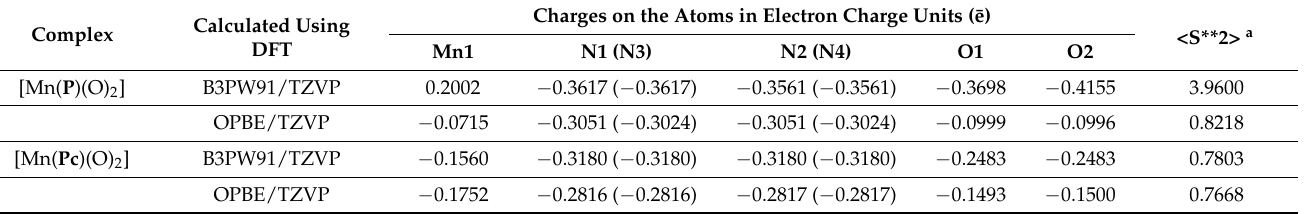
Table 2. NBO analysis data for the [Mn( P )(O) 2 ] and [Mn( Pc )(O) 2 ] complexes in the ground